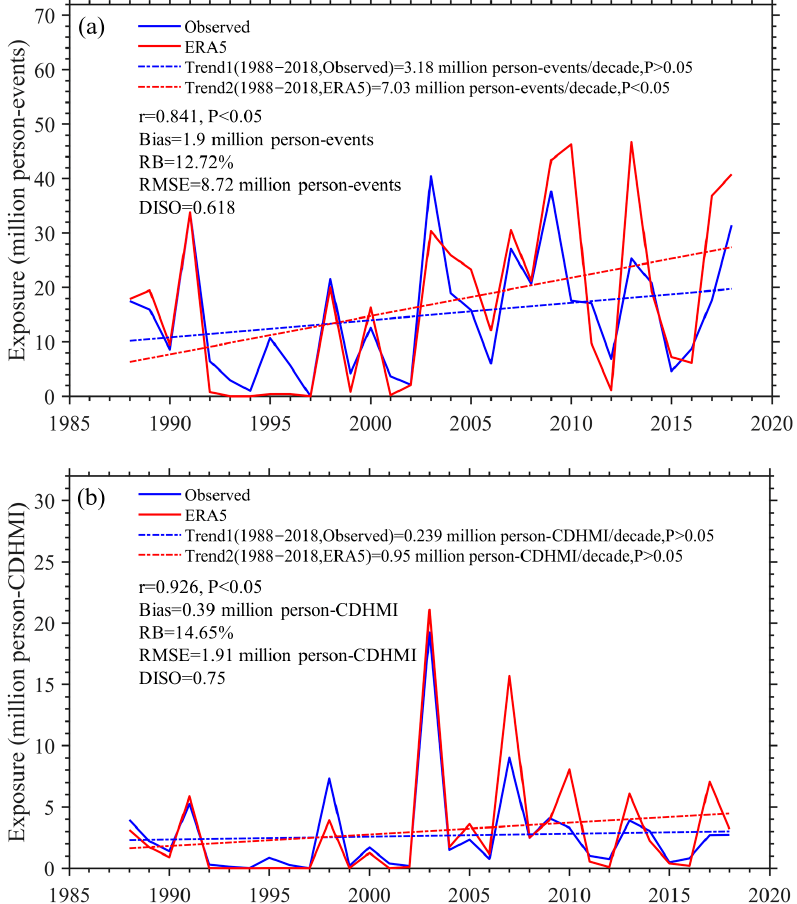
Figure 11. Variations of annual population exposure to ( a ) CDHW frequency and ( b ) CDHMI from 1988 to 2018 in the GRB.